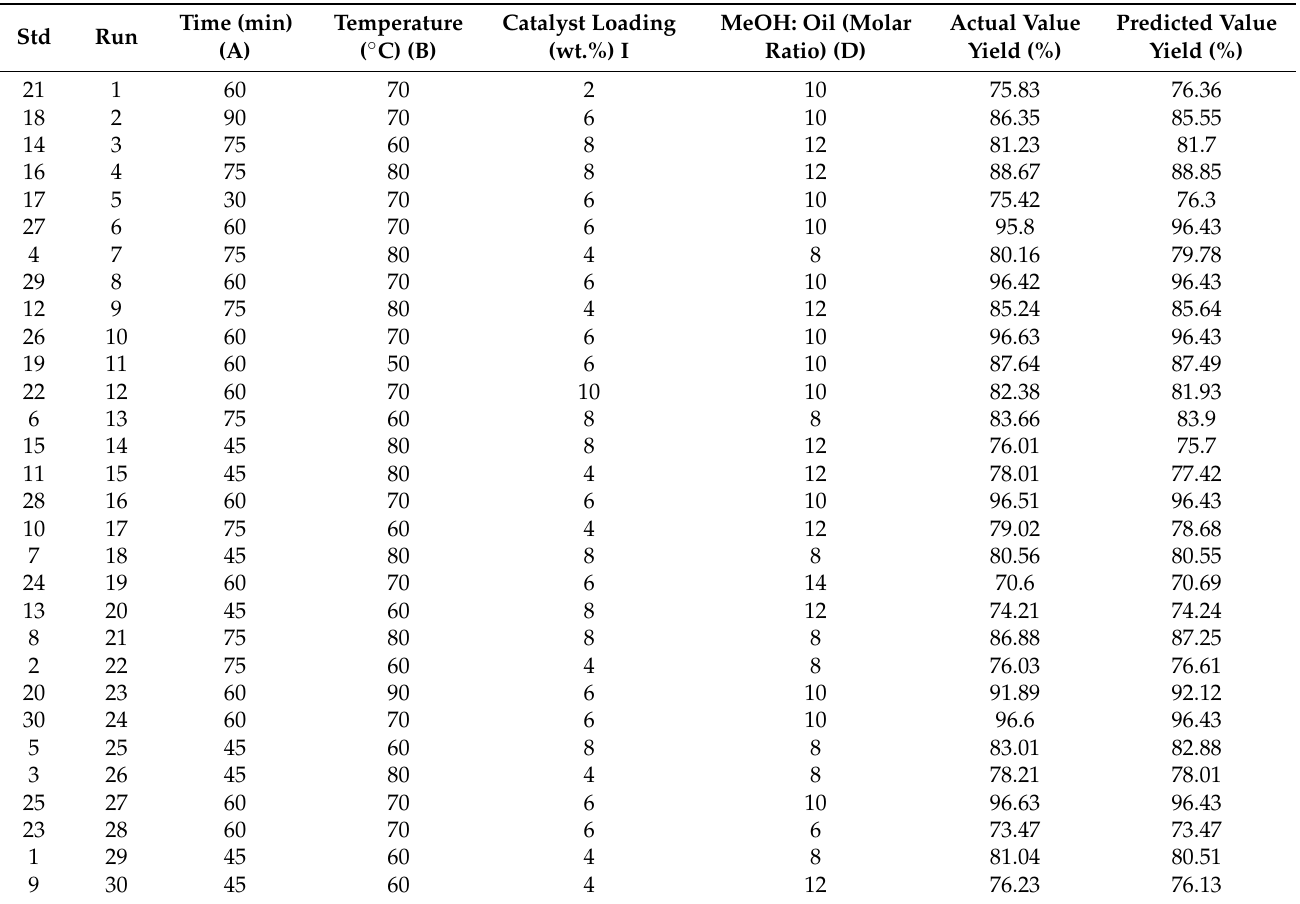
Table 2. Design of experiments for modelling biodiesel yield based on RSM − CCD